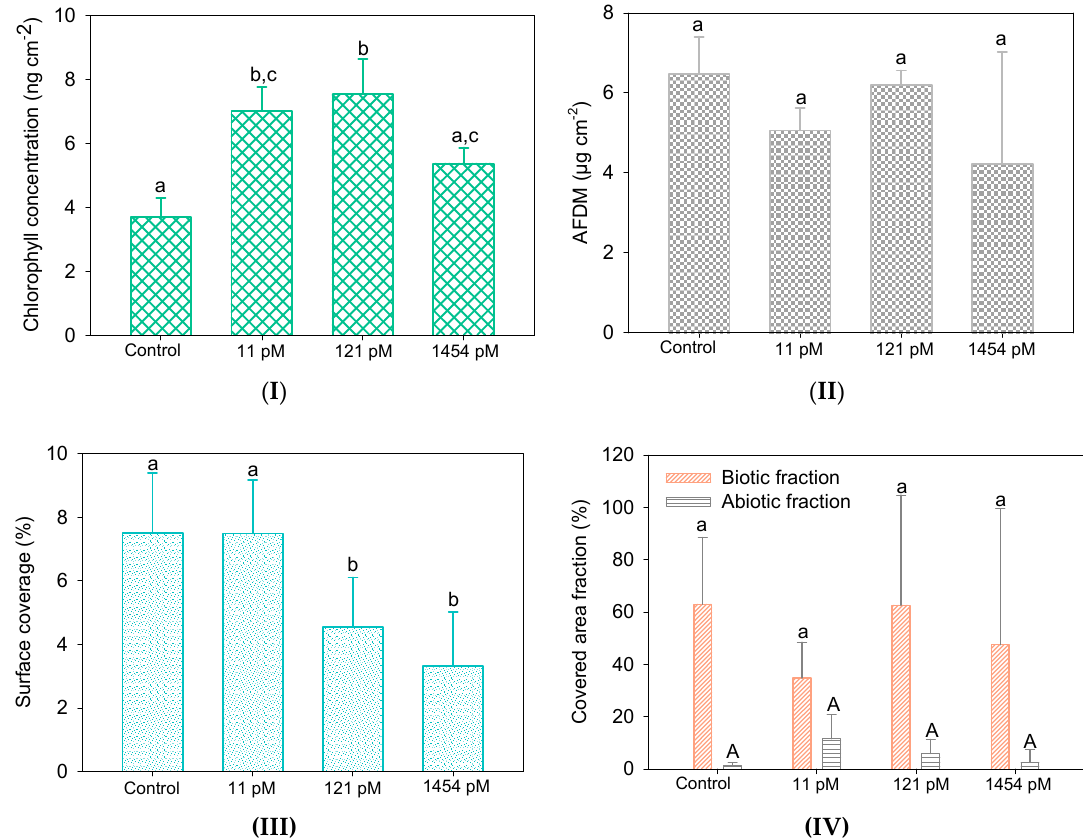
Figure 2. Composition of the control biofilm and biofilms grown in 11 ± 2 pM, 121 ± 9 pM and 1454 ± 54 pM Hg; ( I ) chlorophyll concentration ( n = 3), ( II ) ash-free dry weight (AFDM) ( n = 3), ( III ) surface coverage area ( n = 10) and ( IV ) abiotic and biotic fractions ( n = 10). Letters (a, b, c and A) indicate significant differences between treatments for the studied characteristics ( p < 0.05).